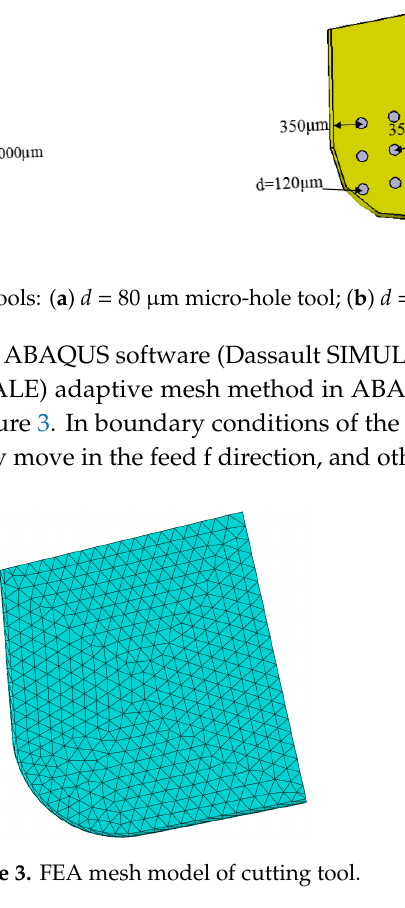
Table 2. GCr15 Johnson-Cook constitutive model parameter